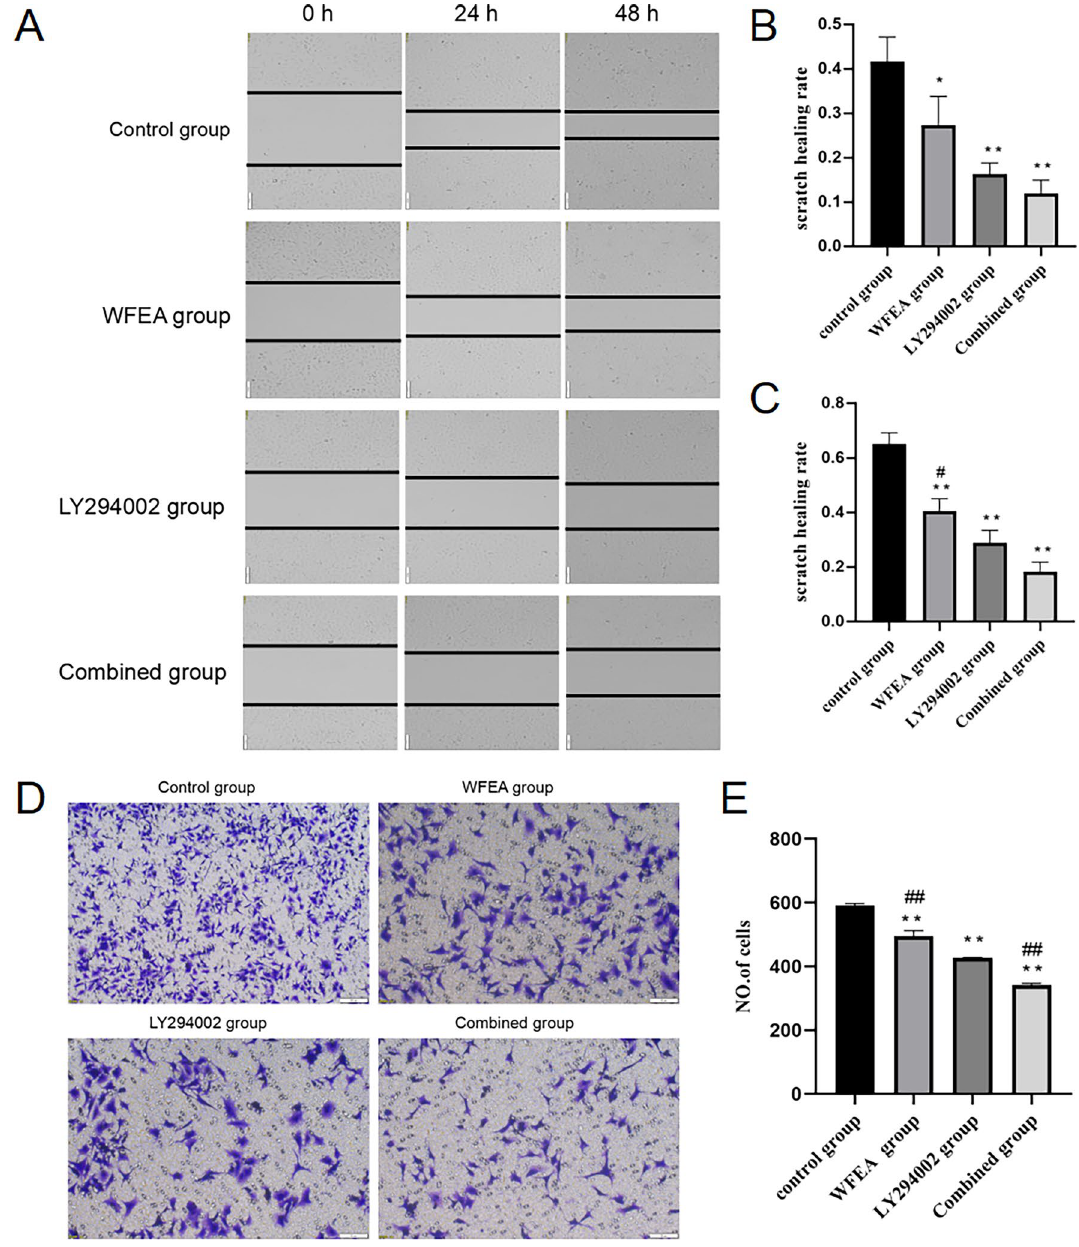
( D ) cell invasion map; ( E ) histogram of invading cell numbers. * p < 0.05 and ** p < 0.01 compared with blank group, # p < 0.05 and ## p < 0.01 compared with LY294002